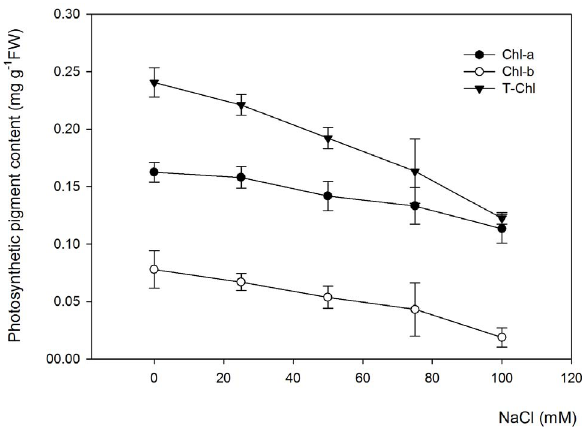
Figure 1. The effects of various NaCl concentrations on the photosynthetic pigments of Salvia miltiorrhiza leaves. The photosynthetic pigments measured in the experiment include chloro- phyll a (Chl-a), chlorophyll b (Chl-b) and total chlorophyll contents (T- Chl). Salvia miltiorrhiza seedlings were cultivated in 1/2 Hoagland nutrient solution for 3 weeks and were later exposed to salt stress by adding NaCl up to concentration of 25, 50, 75 and 100 mM of the hydroponic solution for 30 days. Non-treated plants were used as controls (0 mM NaCl). Error bars represent the standard errors (SE) of the